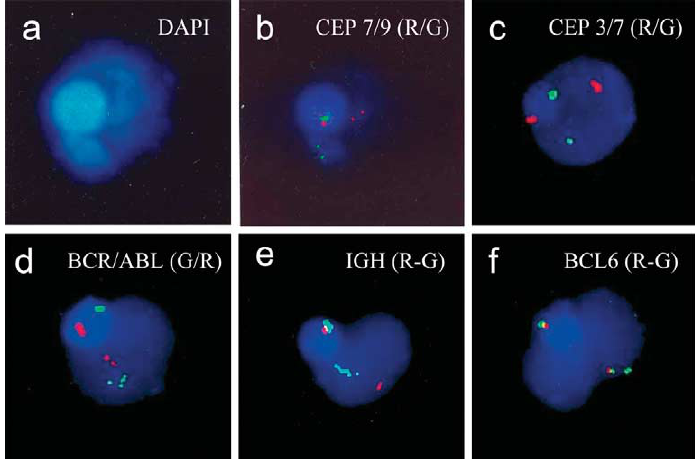
Fig. 1. Biphasic nuclei with its condensed and non-condensed chromatin areas apparently represent the two genomes of a diploid nucleus. Photomicrographs of a biphasic nucleus from bone marrow with DAPI filter (a) and triple band pass showing signals specific to chromosomes HSA 7 red and HSA 9 green (b). Distribution of signals of HSA 3 red and HSA 7 green in a biphasic nucleus from blood (c). In the non-condensed area homologous FISH signals are often either bipartite (b), or extended (d, e and f), indicating advanced replication or enhanced